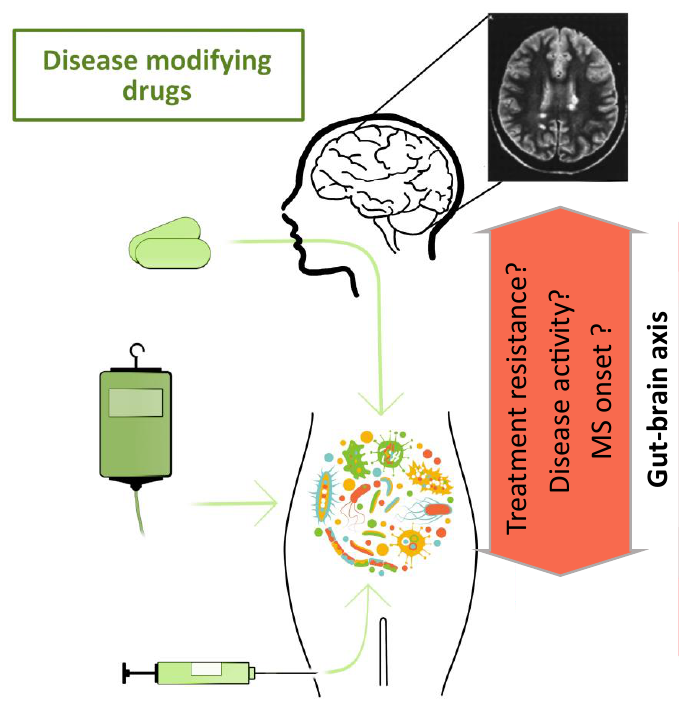
Figure 2. Schematics of the role of the gut-brain axis in the course and treatment of multiple sclerosis .